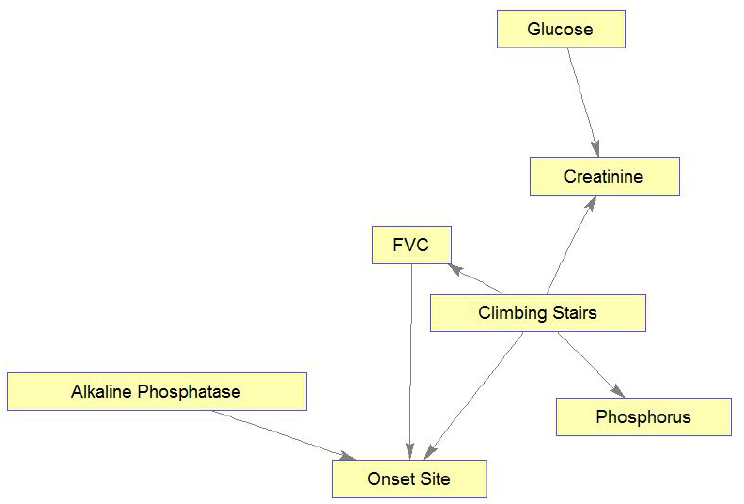
Figure 10. Markov blanket for Swallowing.